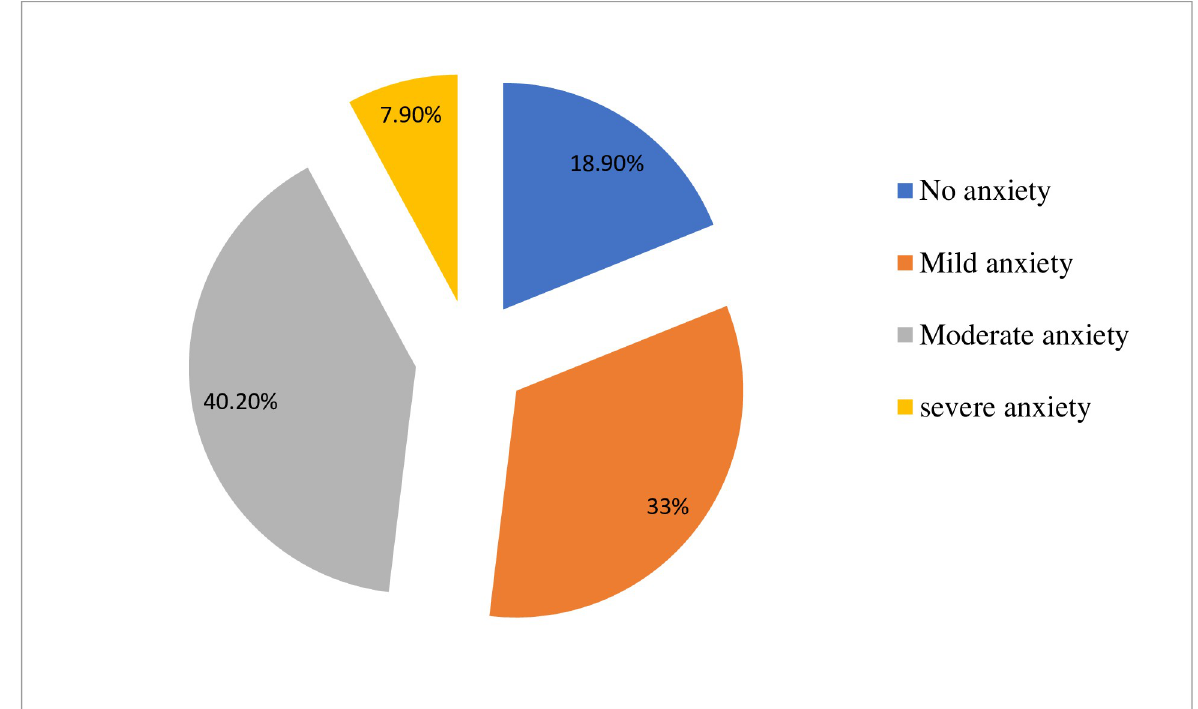
Fig 3. A chart showing the severity levels of anxiety symptoms among study participants in the study. unemployed (AOR = 3.00, 95% CI: 1.22, 7.03, P-value = 0.001), blind (AOR = 2.8, 95% CI: 1.42, 6.35, P-value = 0.001), deaf (AOR = 10.2, 95% CI: 4.52, 35.33, P-value = 0.002) and lep- rosy victim (AOR = 21.4, 95% CI: 4.03, 32.65, P-value = 0.001) participants as compared to their reference groups. Details concerning the associated factors for anxiety, depression and